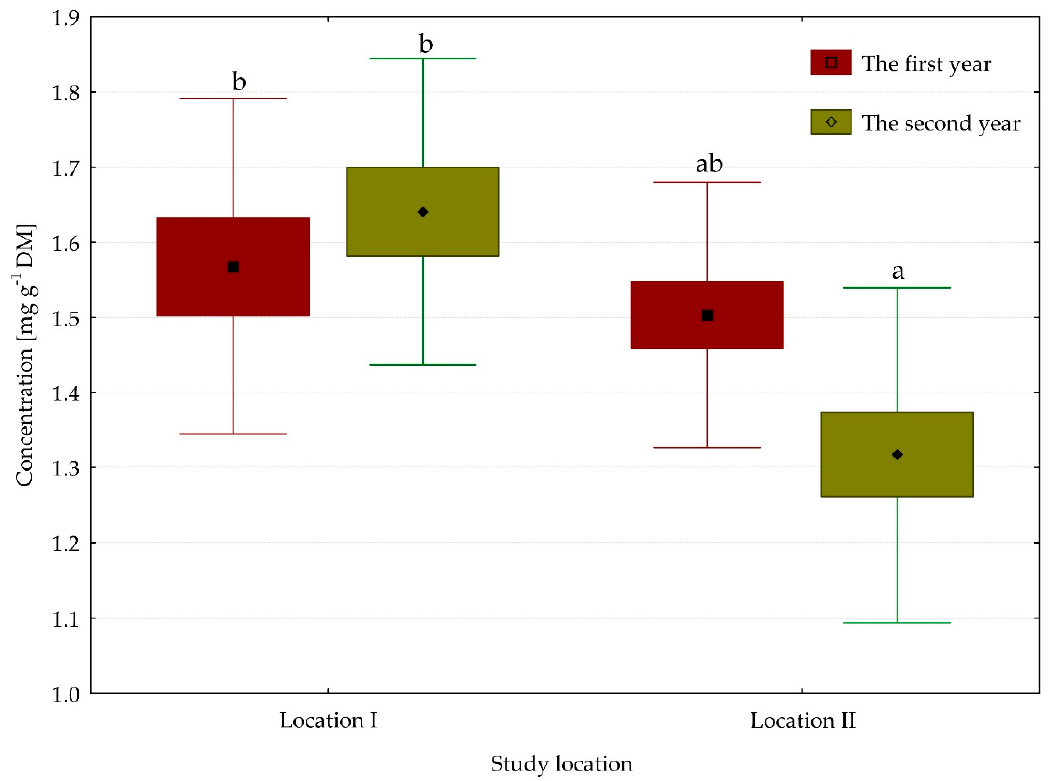
Figure 6. Carotene sum content in Melica nutans leaf blades from two natural forest stands.